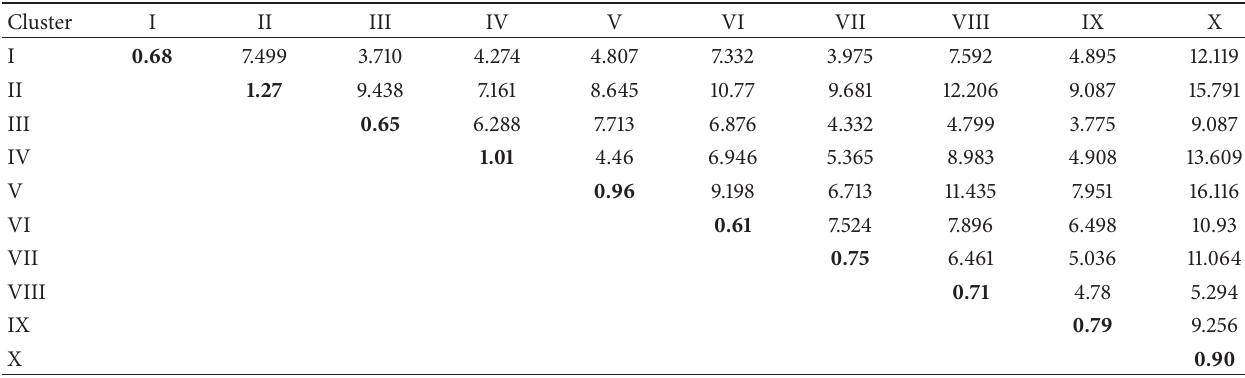
Table 10: Average intra- (bold) and intercluster distances ( 𝐷 2 ) for 113 aromatic and fine rice genotypes. Cluster